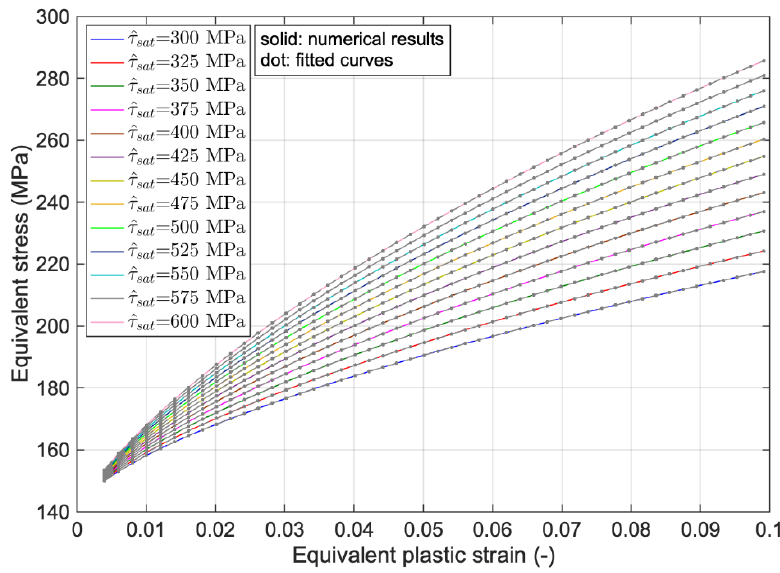
Figure 5. Comparison between numerical results and fitted curves with change in ˆ τ sat